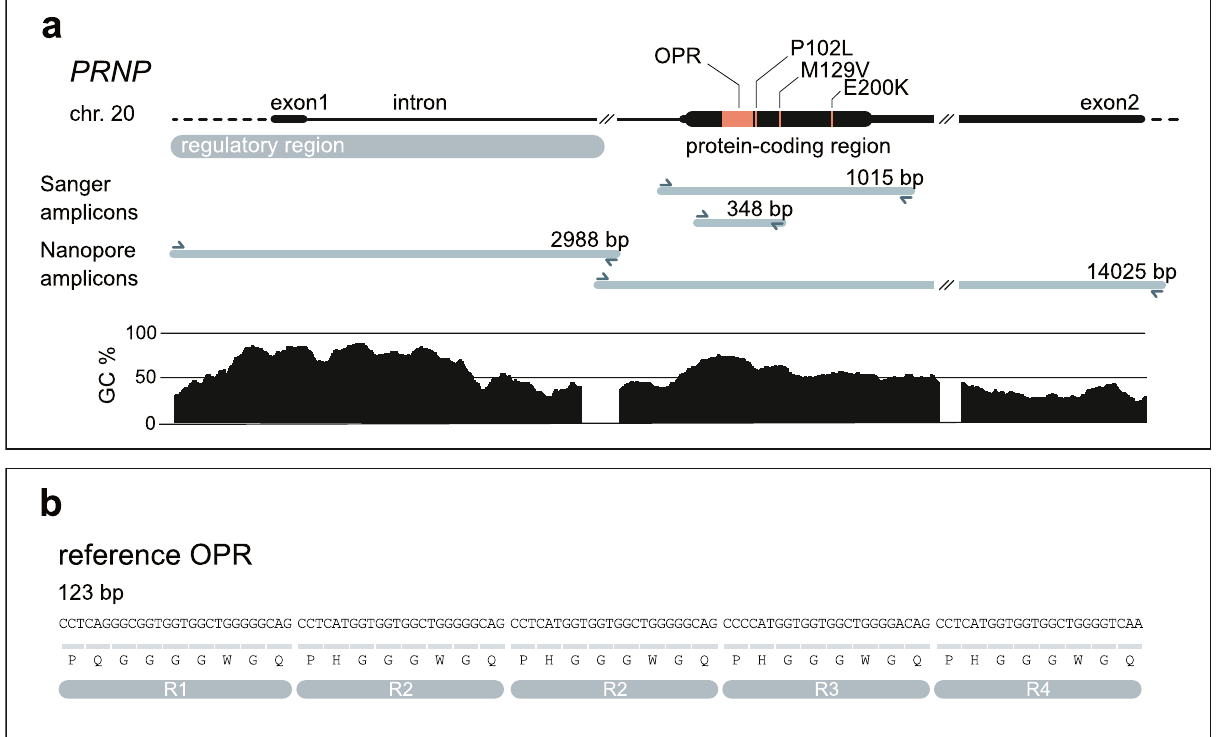
Figure 1. Nanopore sequencing of PRNP and octapeptide repeat genotyping. ( a ) The human PRNP gene. Important pathogenic variants, such as deletions/insertions in the octapeptide repeat region (OPR), codon 129 (M129V) or codon 200 (E200K) SNVs are indicated in the protein-coding region in orange. Genetic diagnosis at the MRC Prion Unit at UCL is performed by Sanger sequencing of the protein-coding sequence (1015-bp amplicon) or specifically of the OPR (348-bp amplicon). Exon 1 and the beginning of the intron are particularly GC-rich (see GC % plot). This likely explains why producing a single amplicon spanning the entire genomic region was technically challenging. Instead, we amplified PRNP in two overlapping fragments for Nanopore sequencing (see Nanopore amplicons). ( b ) Sequence of PRNP ’s OPR. The OPR is composed of five similar repeats for a total of 123 bp. The first repeat (R1) is 27 bp and encodes a sequence of 9 amino acids (nonapeptide), the subsequent ones (R2, R2, R3, R4) are 24 bp and all encode the same sequence of 8 amino acids (octapeptide). The two R2 repeats are identical. R2 vary with R3 and R4 by two nucleotides at wobble